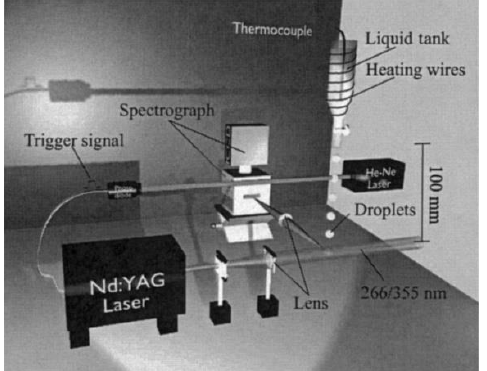
Figure 16. Experimental device for single-droplet temperature measurement [130]. Reprinted with permission from [130]. Optica Publishing Group, 2004.